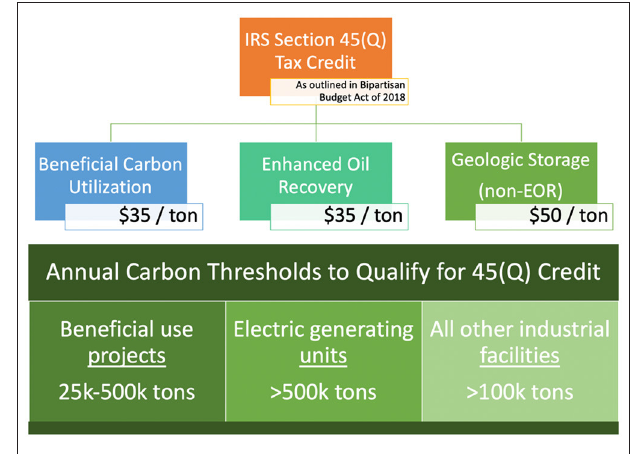
FIGURE 4 | Section 45(Q) policy